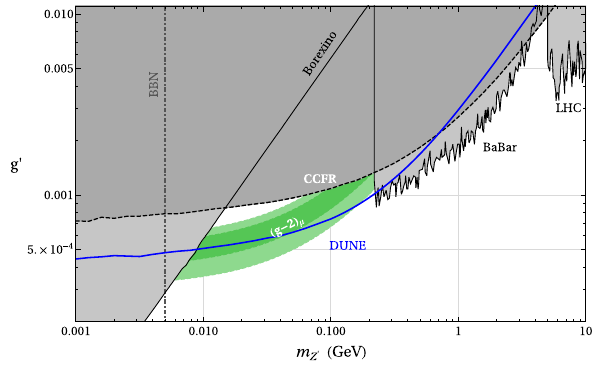
Fig. 17 Existing constraints and projected DUNE sensitivity in the L μ − L τ parameter space. Shown in green is the region where the ( g − 2 ) μ anomaly can be explained at the 2 σ level. The parameter regions already excluded by existing constraints are shaded in gray and correspond to a CMS search for pp → μ + μ − Z (cid:5) → μ + μ − μ + μ − [160](“LHC”),aBaBarsearchfor e + e − → μ + μ − Z (cid:5) → μ + μ − μ + μ − [161] (“BaBar”), a previous measurement of the trident cross section [146,151] (“CCFR”), a measurement of the scattering rate of solar neu- trinos on electrons [162–164] (“Borexino”), and bounds from Big Bang Nucleosynthesis [165,166] (“BBN”). The DUNE sensitivity shown by the solid blue line assumes 6 years of data running in neutrino mode,